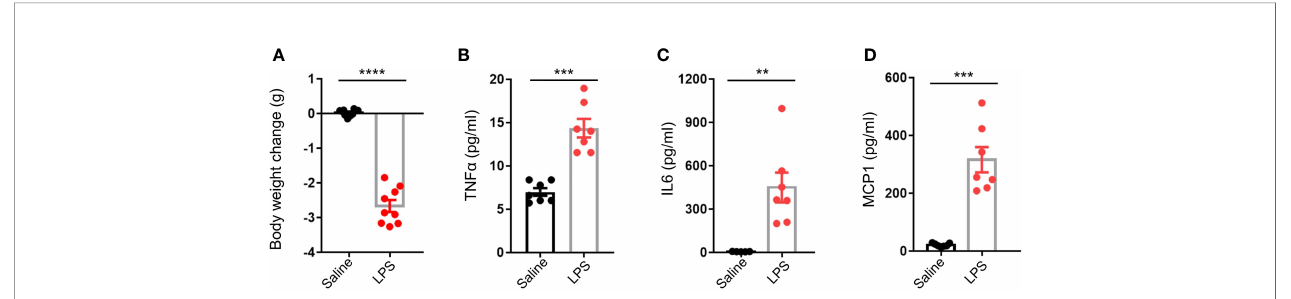
FIGURE 1 | LPS treatment resulted in an elevation of circulating in fl ammatory cytokines. (A) LPS treatment resulted in lower mice body weight (data are presented as mean ± SEM, n = 9 saline, n = 9 LPS, Student ’ s t-test, **** p < 0.0001). (B – D) LPS treatment resulted in higher plasma levels of tumor necrosis factor alpha (TNF a ), interleukin 6 (IL6), and monocyte chemoattractant protein 1 (MCP1) compared to controls (data are presented as mean ± SEM, n = 5 – 7 saline, n = 7 LPS; Student ’ s t-test, ***p < 0.001, **p <